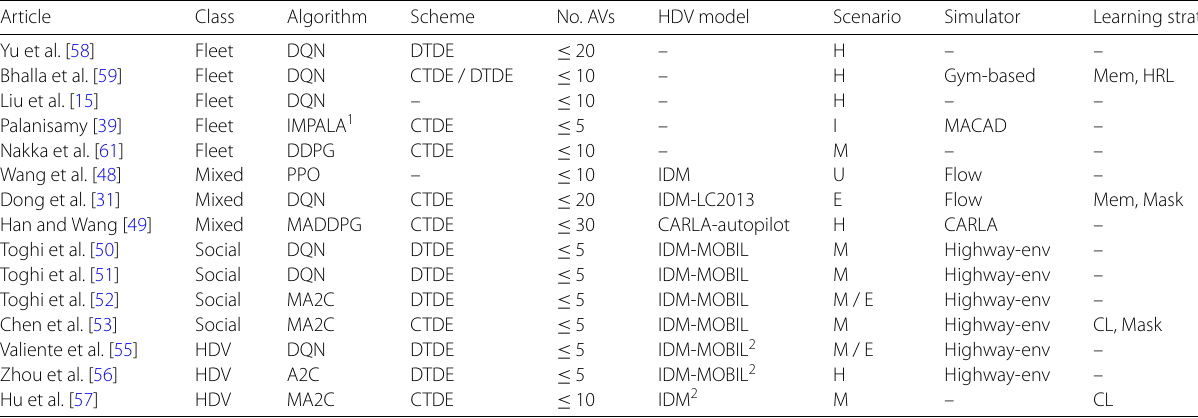
Table 1 Summary of papers according to the problem addressed and simulation settings. Scenarios include merging (M), exiting (E), highway (H) without merging nor exiting, urban navigation comprising intersections and roundabouts (U), and intersection (I). Learning strategies include Hierarchical Reinforcement Learning (HRL), Curriculum Learning (CL), Memory module (Mem), and Masking